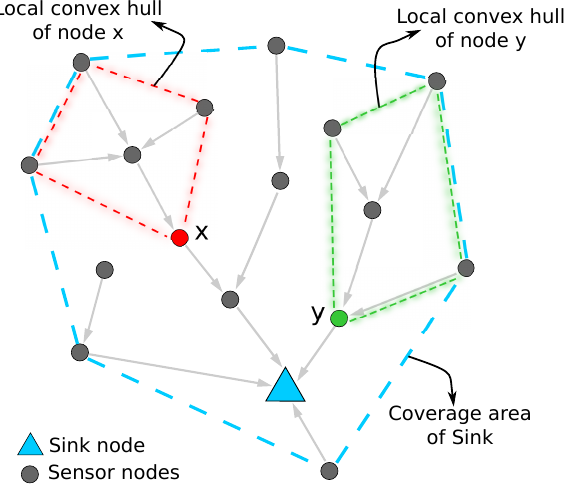
Figure 1. Example network with coverage area ( i.e. , convex hull stored in the sink) and local convex hulls stored in sensor